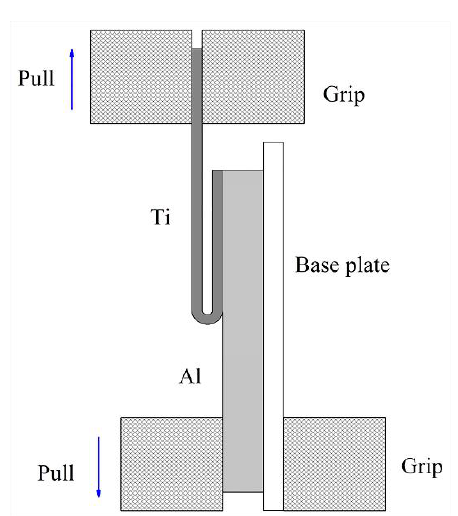
Figure 2. Schematic diagram of 180° peel test of the Ti/Al laminated composites.